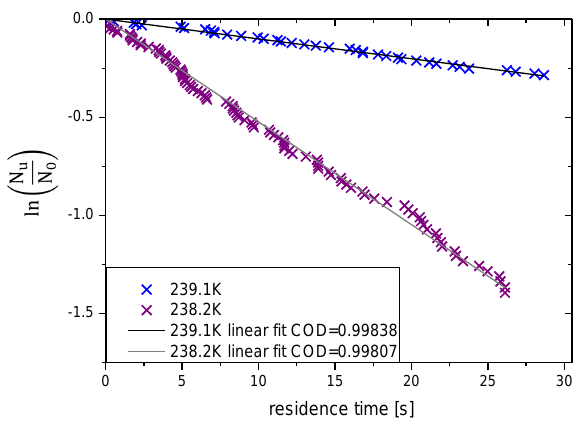
Fig. 8. Freezing probability as a function of temperature. Green diamonds represent the results from the experiment with kaoli- nite KGa-1b with a mobility diameter of d m = 550nm. The tri- angles shows the results of the experiments with hematite (blue: d m = 970nm; magenta: d m =